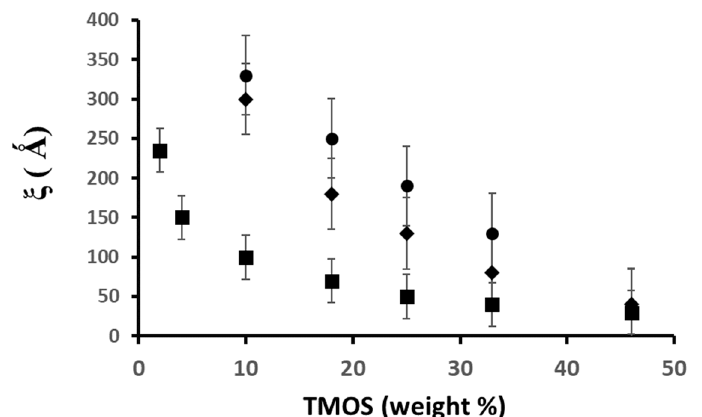
Figure 6. Evolution of ξ versus TMOS concentration for the different catalysis conditions:.base ( (cid:4) ), neutral ( (cid:7) ), acid ( •